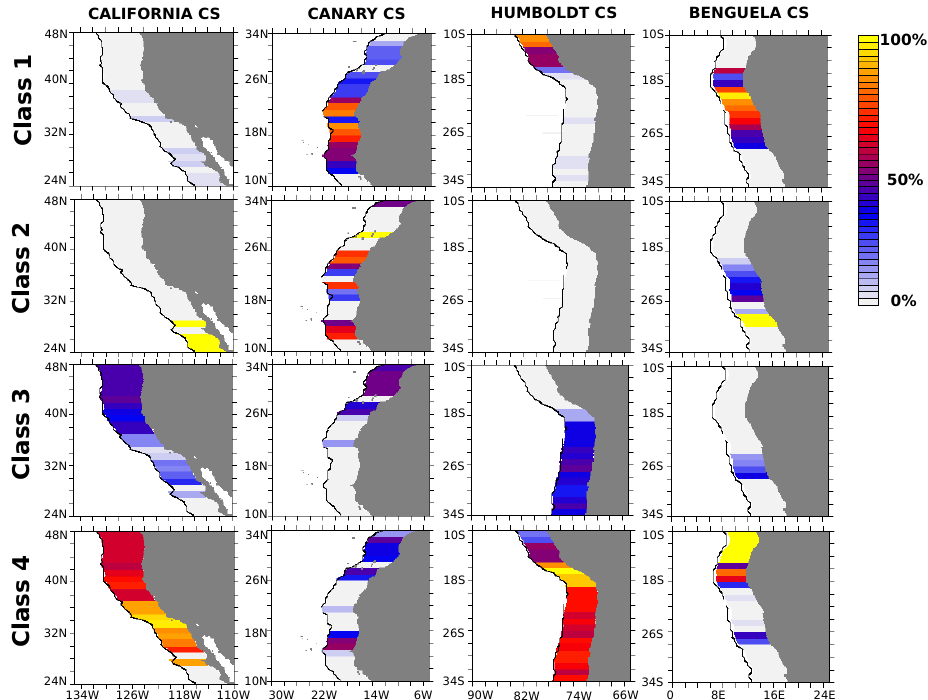
Fig. 10. Spatial distributions of the 4 classes presented in Fig. 7. For each meridional bin in the four EBUS we plotted the proportion of observations belonging to each of the 4